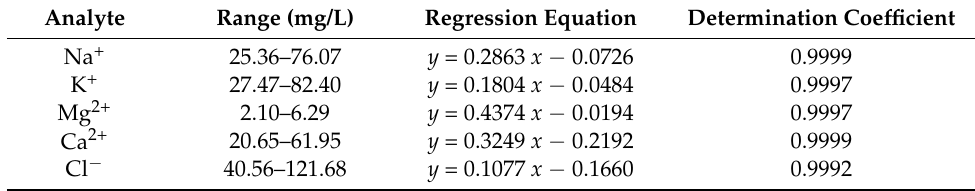
Table 5. Regression data for Na + , K + , Mg 2+ , Ca 2+ and Cl − .